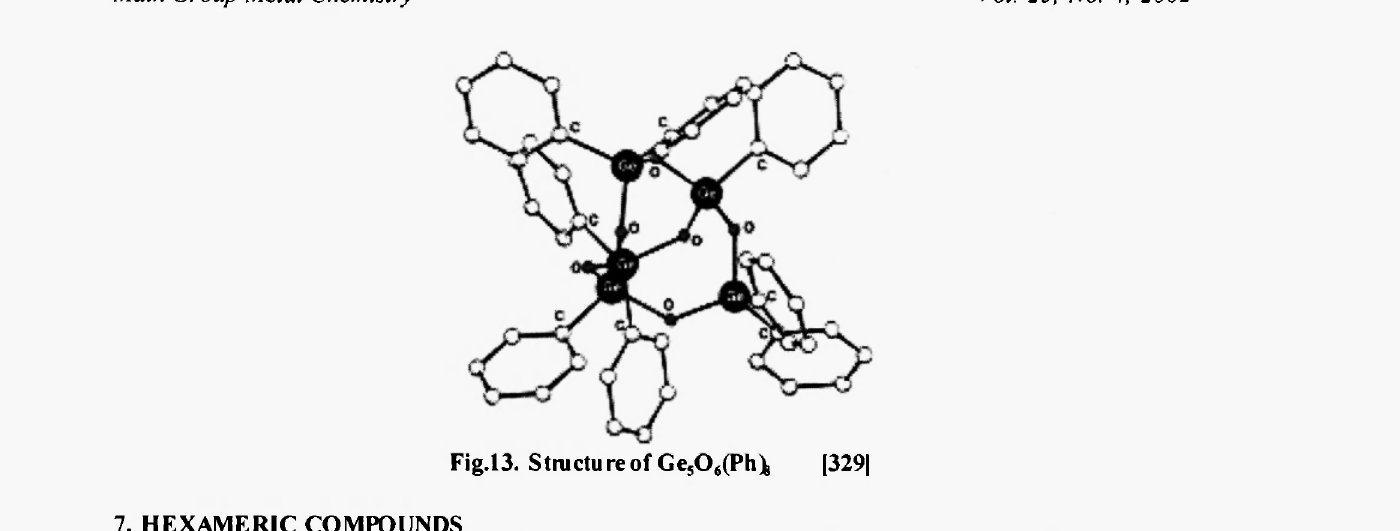
Fig.13. Structure of Ge 5 0 6 (Ph^ [329|